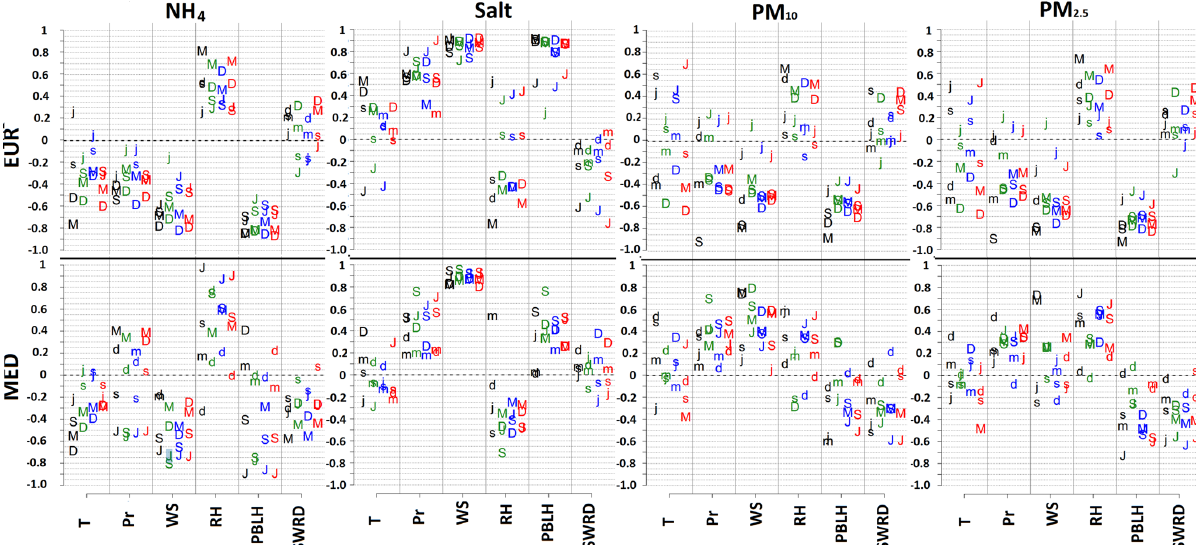
Figure 11. Correlation coefficient between all meteorological parameters tested and ammonium (NH + all seasons and the EUR and MED subdomains. D, M, J and S represent winter, spring, summer and fall, respectively (first letter of the first month of each season). Uppercase letters mean that the correlation between the two parameters is statistically significant, whereas lowercase letters show the contrary. Color coding for different scenarios is the same as in previous figures. SWRD represents shortwave